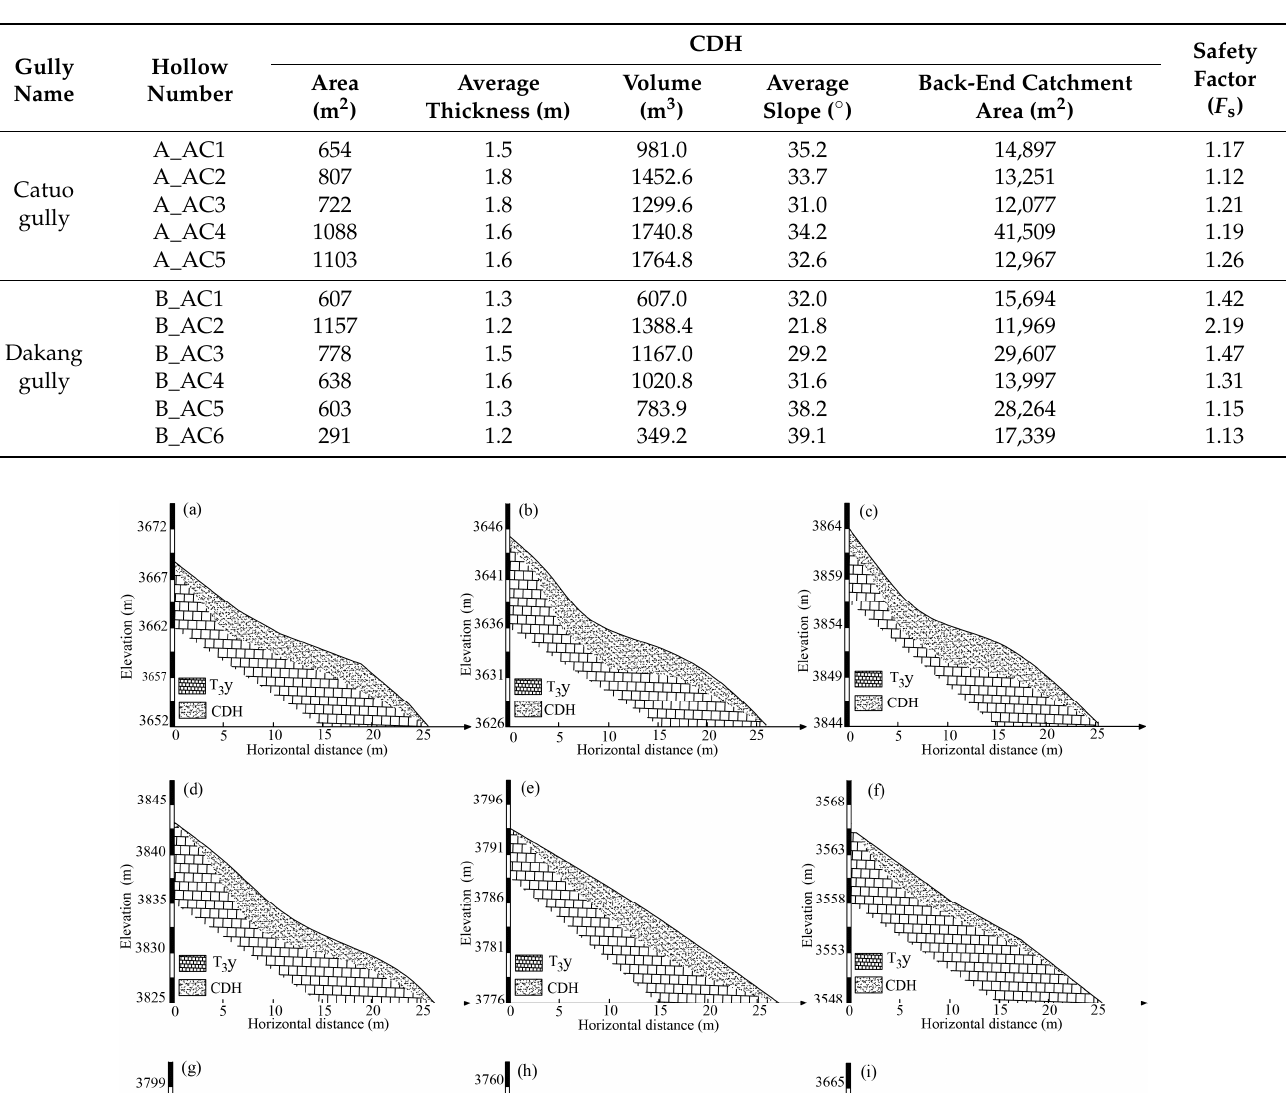
Table 2. Geometric parameters of the CDH of the Catuo gully and the Dakang gully.